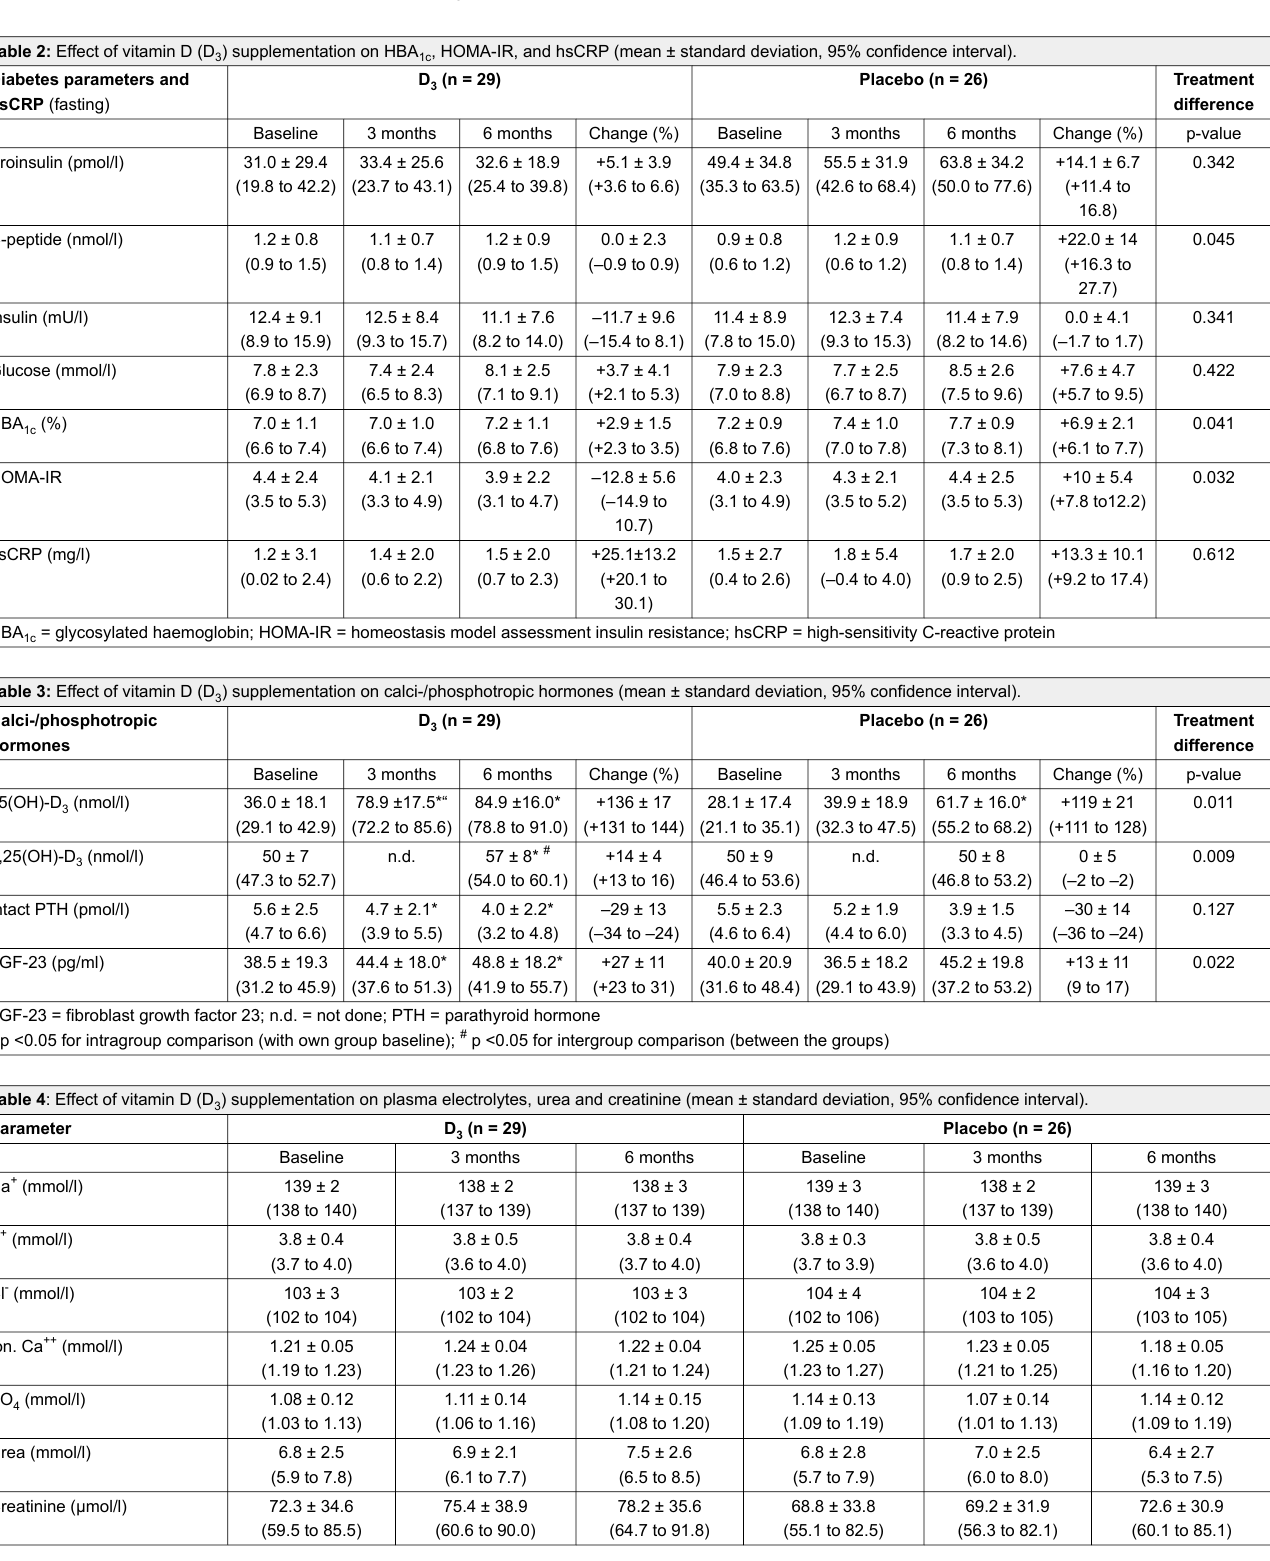
Table 2: Effect of vitamin D (D 3 ) supplementation on HBA 1c , HOMA-IR, and hsCRP (mean ± standard deviation, 95% confidence interval). Diabetes parameters and hsCRP (fasting)